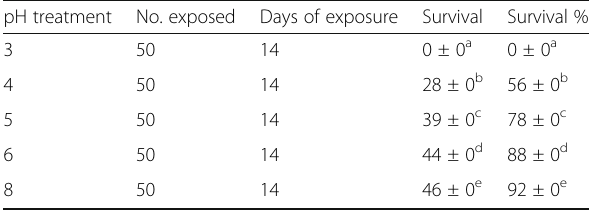
Table 2 Mean survival of O. niloticus juveniles in low pH and control pH